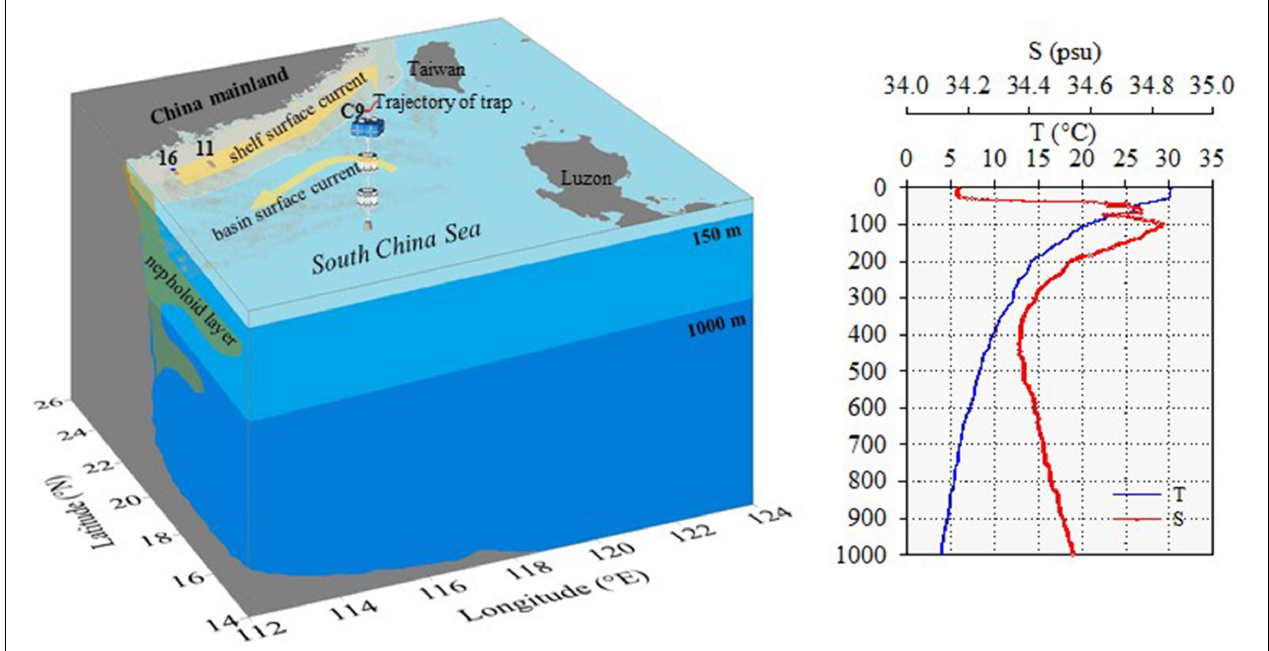
FIGURE 1 | Sampling locations for seawater samples (C9), sediment trap samples (C9), and surface sediments (Stations 11 and 16) in the northeastern South China Sea (left) and the distributions of temperature and salinity at station C9 (right). The green shade represents the dispersion of resuspended sediment along the slope below the euphotic zone. The yellow arrows highlight the surface currents in the northern SCS during